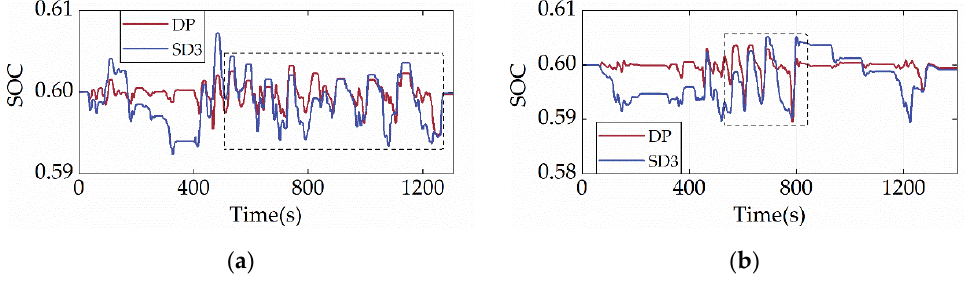
Figure 9. SOC trajectories under different driving cycles. ( a ) CHTC-B; ( b ) WVUCITY.